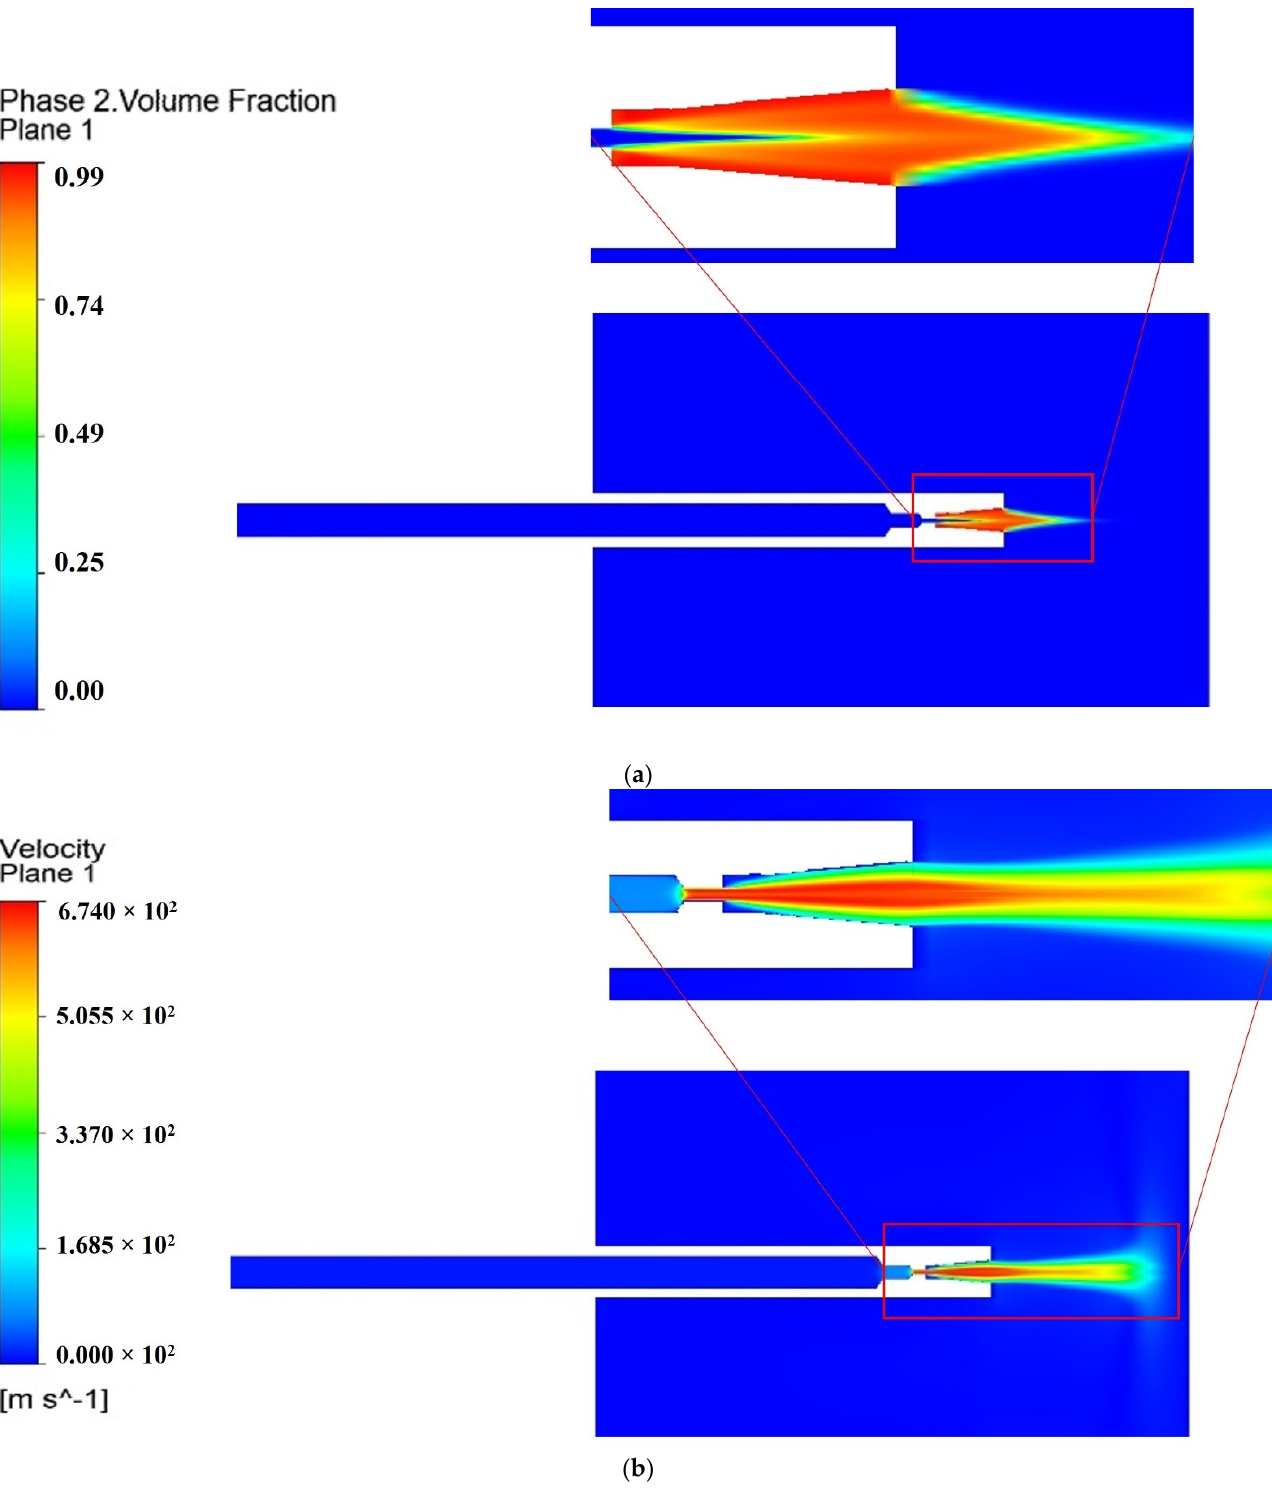
Figure 6. Cavitation effect of nozzle and jet velocity clouds: ( a ) cavitation effect cloud; ( b ) jet velocity cloud.